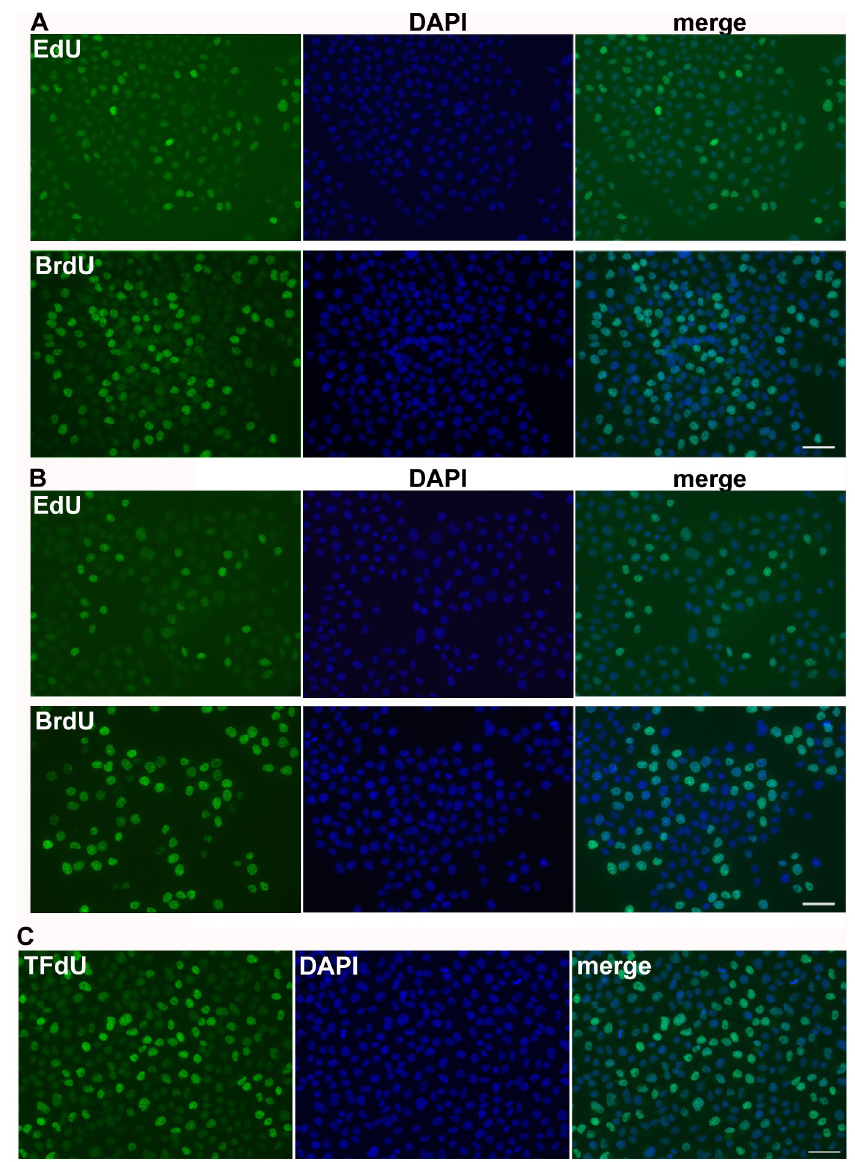
Fig 4. Fluorescence images of BrdU, EdU and TFdU. (A, B) The detection of EdU and BrdU in HeLa cells labelledwith EdU or BrdU for 5 minutes and fixed with formaldehyde (A) or ethanol(B). EdU and BrdU are in green, DAPI is in blue. The scale bar—50 μ m. ( C) The detectionof TFdU. HeLa cells were labelledwith TFdU for 30 min. TFdU was revealedby optimizedmethod and detected by anti-BrdU antibodyclone 3D4. TFdU is in green, DAPI is in blue. The scale bar—50 μ